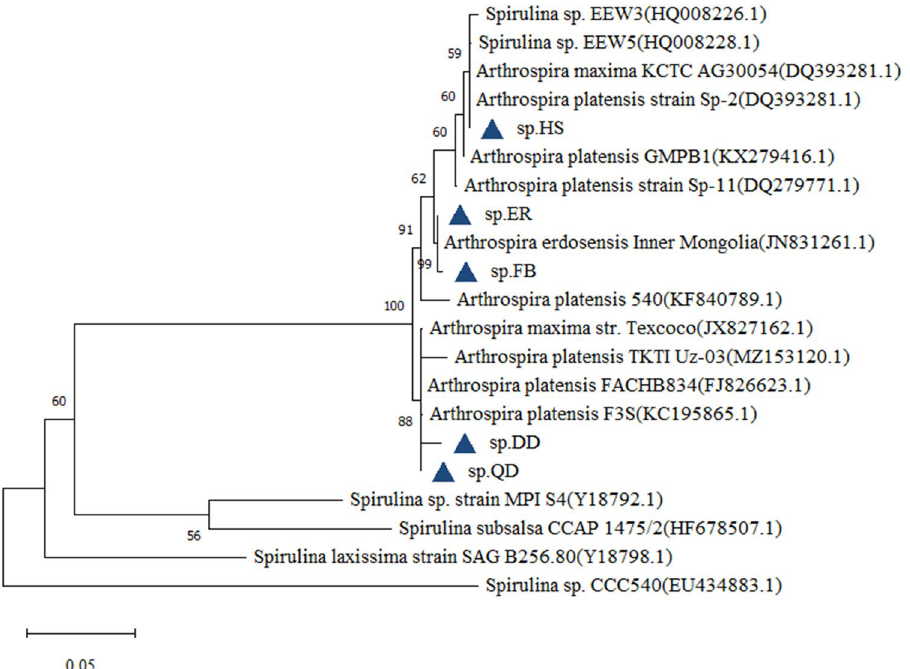
Figure 5. Molecular Phylogenetic analysis based on 16S rRNA-ITS by Maximum Likelihood